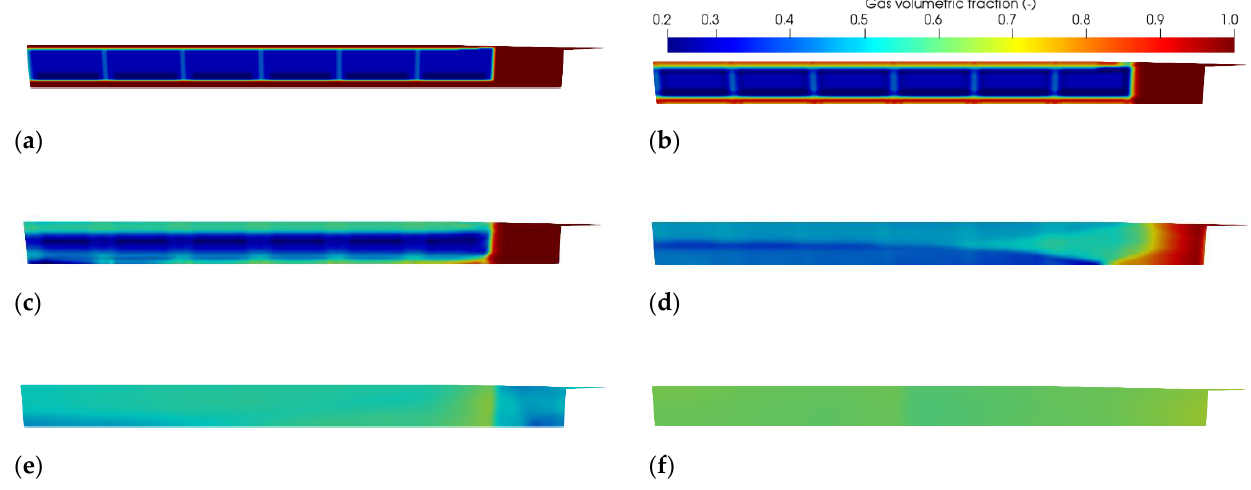
Figure 9. 2D Axisymmetric numerical results for 155/52 six-module charge firing test. Gas volumetric fraction α 1 at different times: ( a ) t = 0; ( b ) t = 1.5 ms; ( c ) t = 3.0 ms, ( d ) t = 4.5 ms; ( e ) t = 6.0 ms; ( f ) t = 7.5 ms.